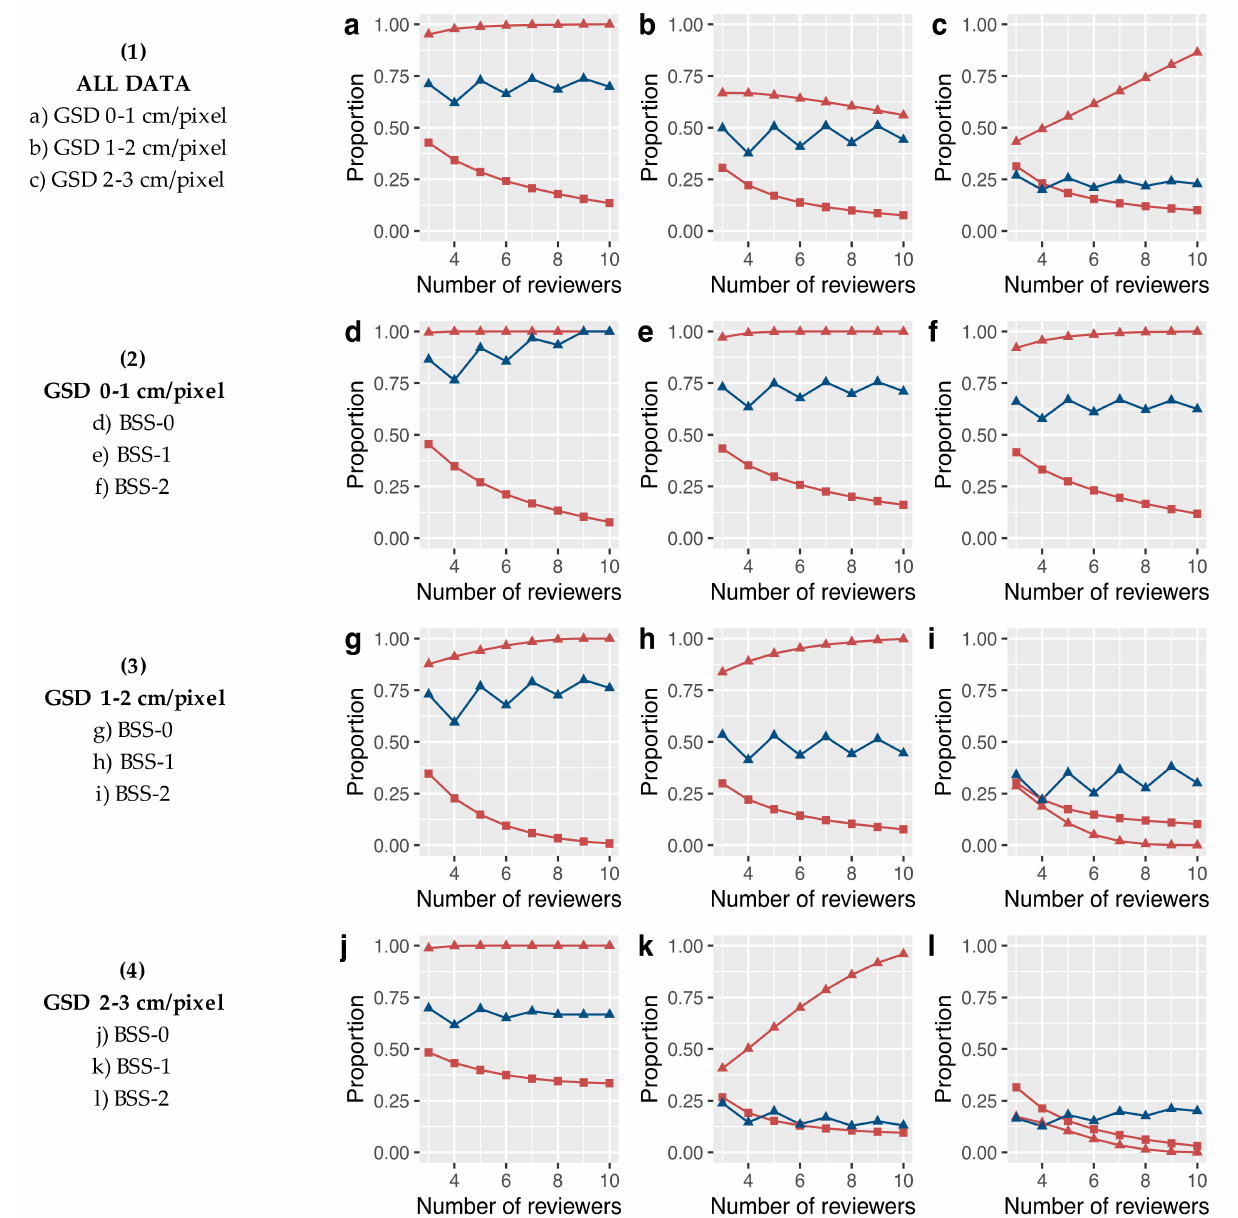
Figure 6. Effect of reviewer group size on the proportion of correct selections (triangles) and the proportion of retained data (rectangles) in the agreement-based framework (red) and the majority-rule approach (blue). Panel 1 displays the above relationship for each of the three ground sample distance (GSD) levels: ( a ) 0–1 cm/pixel; ( b ) 1–2 cm/pixel; ( c ) 2–3 cm/pixel. Panels 2, 3, and 4 depict the same relationship for each of the three Beaufort sea state (BSS) categories in the GSD levels of 0–1 cm/pixel, 1–2 cm/pixel, and 2–3 cm/pixel, respectively: ( d , g , j ) BSS-0; ( e , h , k ) BSS-1; ( f , i , l )